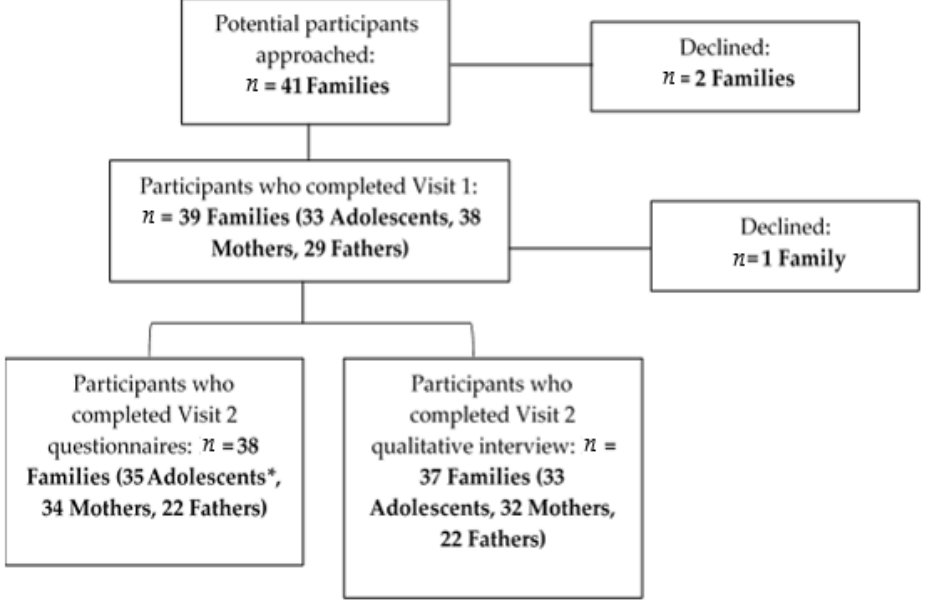
Figure 1. Recruitment flowchart. Participation across study time points. * Three adolescents completed Visit 2 but did not complete Visit 1.